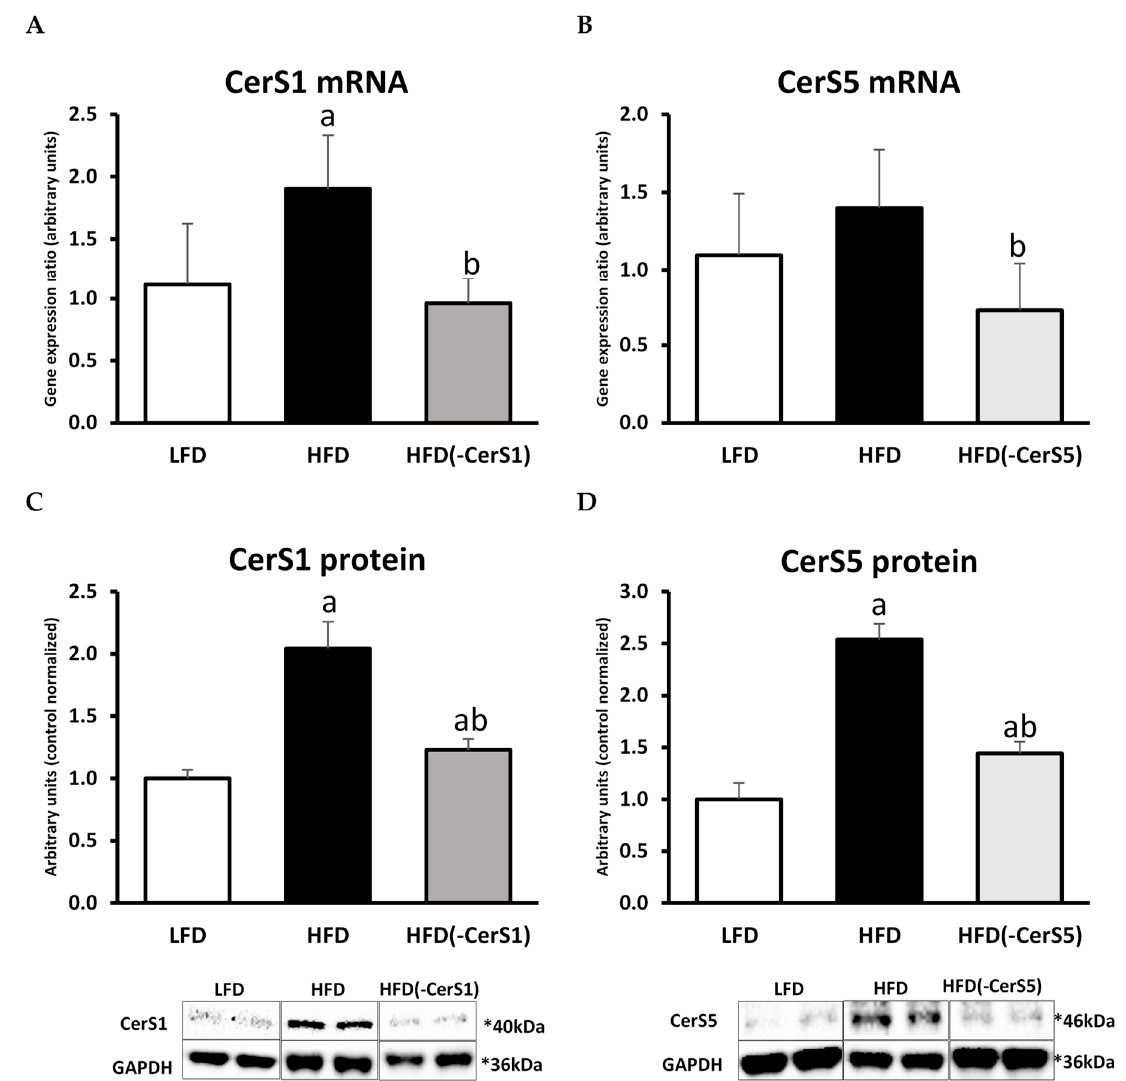
Figure 2. The impact of in vivo CerS1 and CerS5 gene silencing on the mRNA and protein expression of CerS1 and CerS5 in the mouse gastrocnemius muscle: Panels ( A , C )—the expression skeletal muscle CerS1 at the mRNA and protein level, respectively; Panels ( B , D )—the expression skeletal muscle CerS5 at the mRNA and protein level, respectively. Values are mean ± SD ( n = 8 per group); a— p < 0.05 vs. LFD; b— p < 0.05 vs. HFD; significance by ANOVA; LFD-low-fat diet, HFD—high-fat diet. The observed molecular weight of indicated proteins is different to the theoretical one, as stated by the antibody